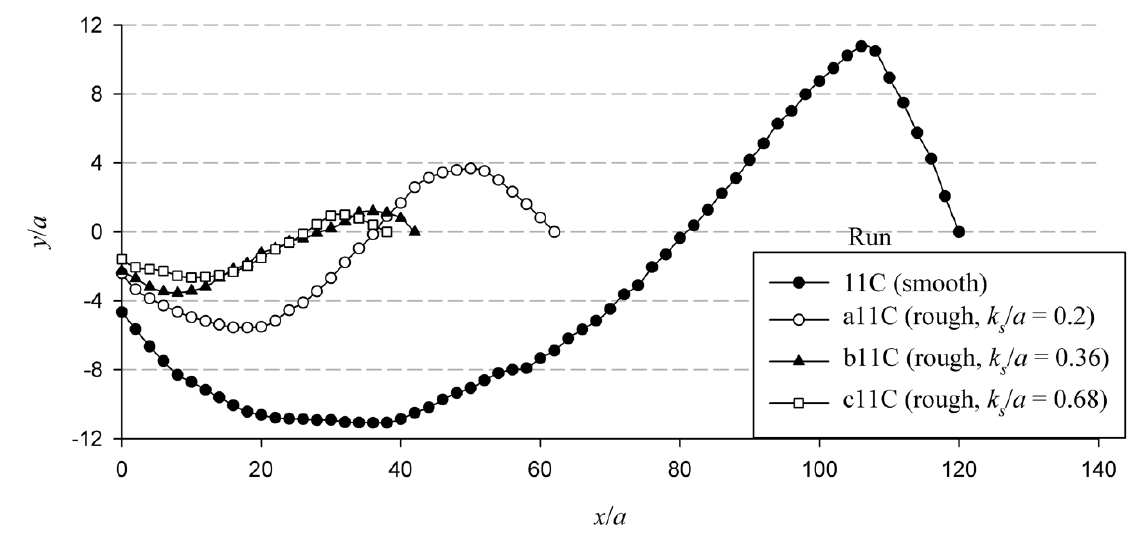
Figure 11. The profiles of equilibrium scour for smooth and rough aprons for various runs. A number of temporal variations of scour profiles for each experimental run were The volume of scour hole per unit width ξ s and deposition of sediment as ridge ξ d can measured. An investigation of non-dimensional profiles of different runs provided in the be obtained as: Appendix A gives the values of the coefficients as m 0 = − 0.15, m 1 = − 0.58, m 2 = 0.114, m 3 = − 0.005, n 0 = 0.934, n 1 = − 0.561, n 2 = 0.077, and n 3 = − 0.003. Figure 12 shows that the normal- ized scour profiles are in good agreement with those computed from Equations (5) and (6). It is concluded from the above evaluation that 22.4% volume of sediment is washed away with the flow.